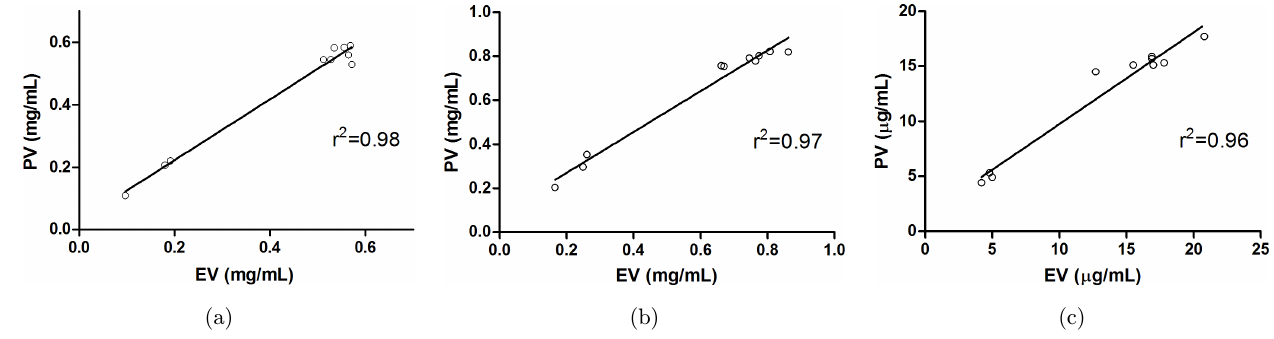
Fig. 7. Experimental values vs. predictive values: secologanic acid (a), chlorogenic acid (b) and galuteolin